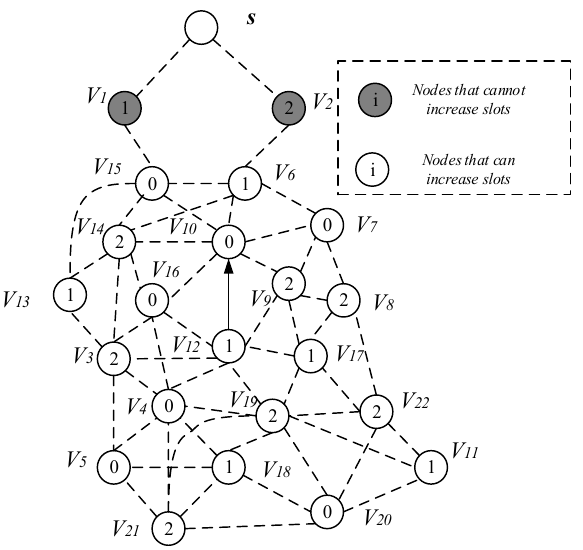
Figure14. Physical link for AAS-LBR. Figure 14. Physical link for